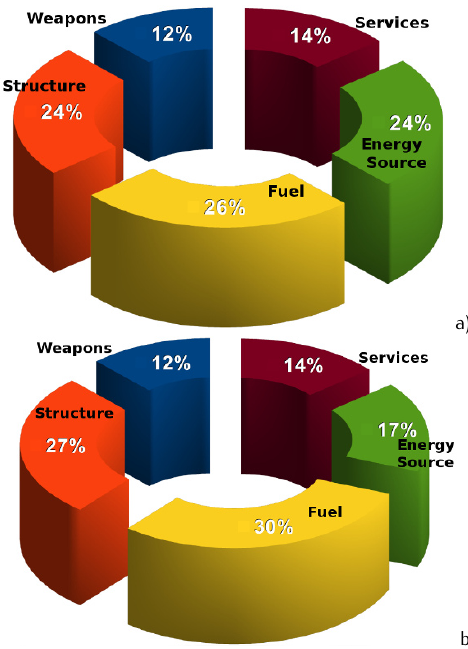
Figure 2. Comparison of mass breakdown for two military planes with similar combat profile. a) Values obtained for a VTOL Harrier. b) Results obtained for a CTOL Skyhawk air- plane. Marked differences between the fuel and energy source (powerplant) can be identified between the